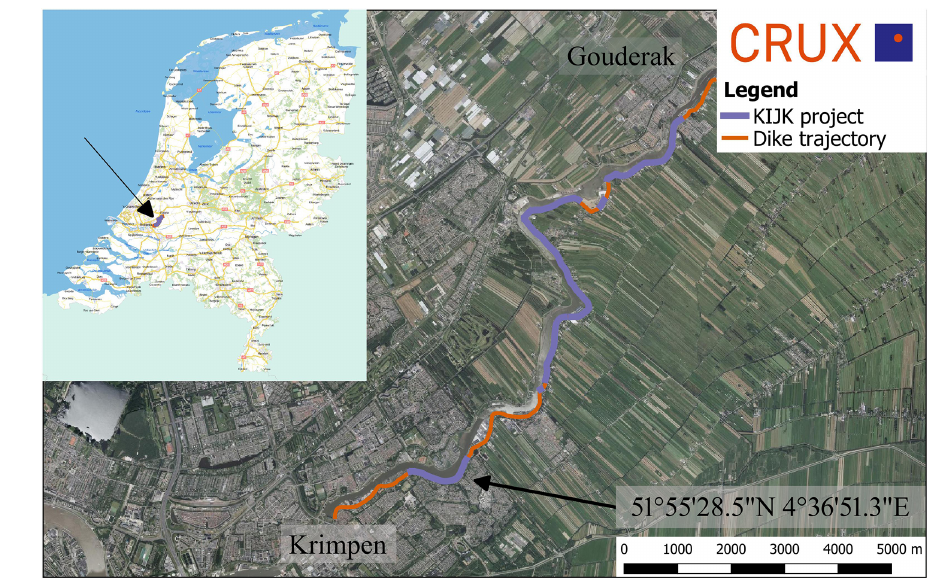
Figure 1. Location KIJK project; Hollandse IJssel between Krimpen – Gouderak [aerial photo 2016; nationaal